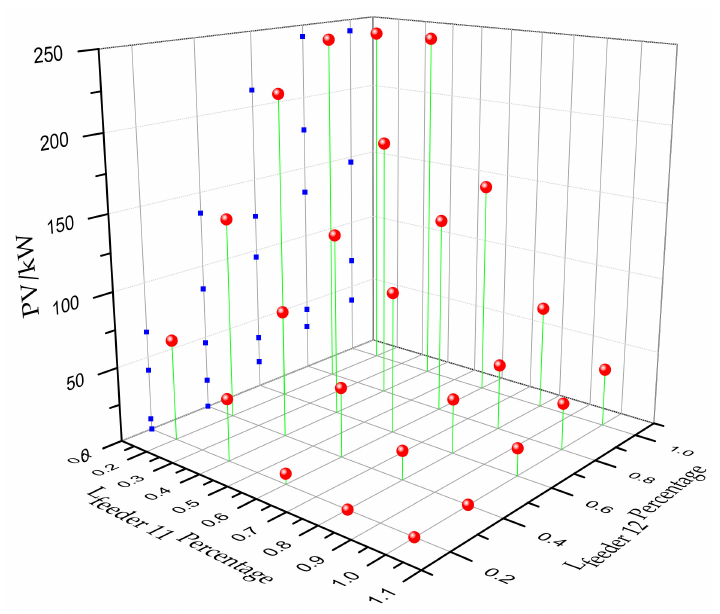
Figure 7. Optimized configuration results for different feeder parameters.